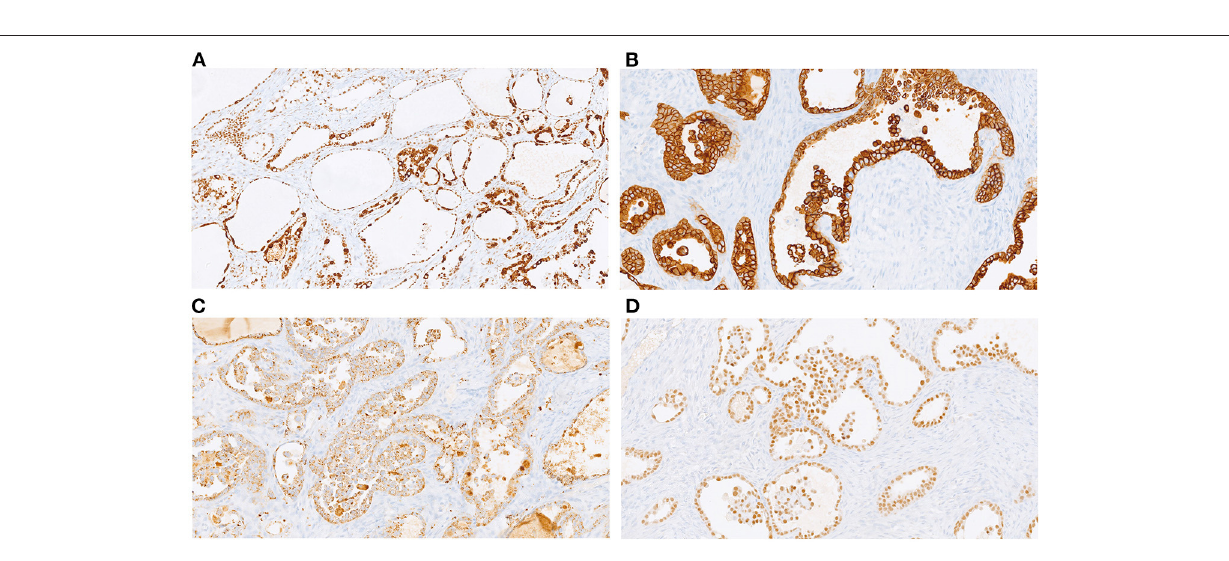
FIGURE 3 | Immunohistochemical profile: diffuse expression of ARID1A ( A , 20x), CK7 ( B ; 20x); napsin-A ( C , 20x), and PAX8 ( D ;